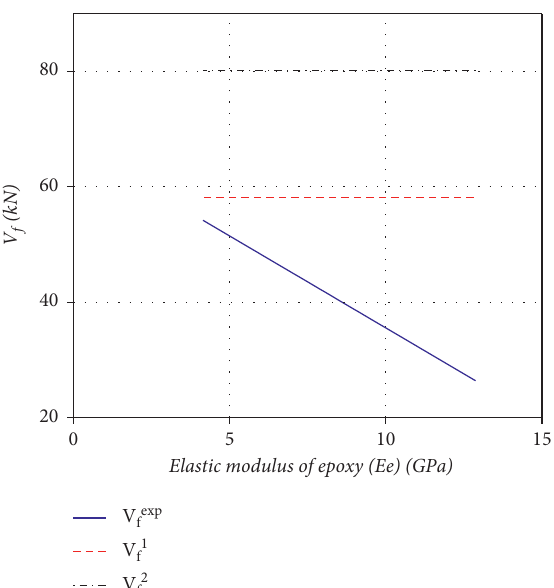
Figure 6: Effect of the elastic modulus of epoxy on the contribution of the NSM FRP shear strengthening technique (the experimental FRP contribution gained from [26]).